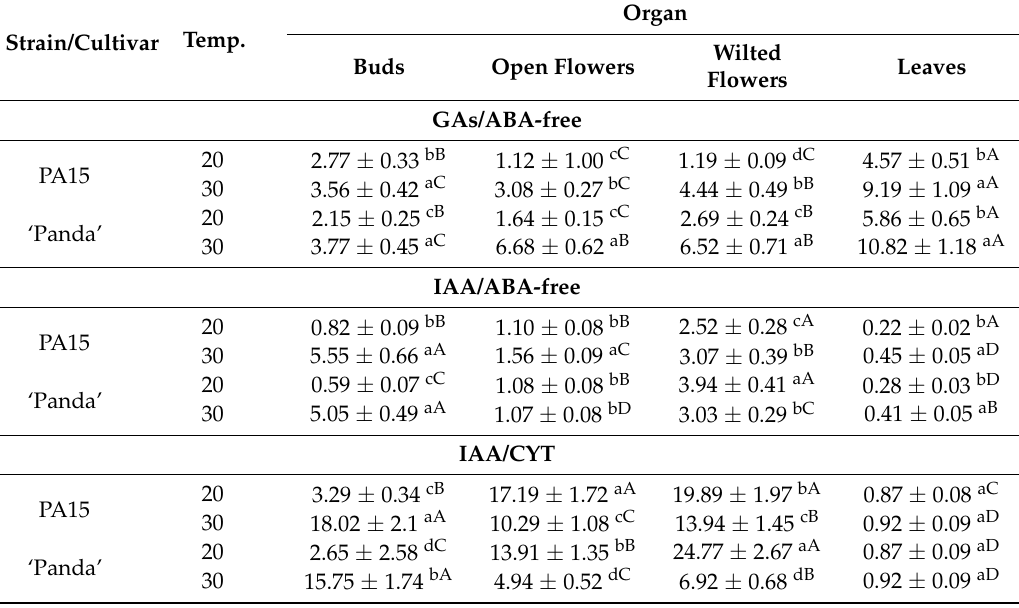
Table 4. Ratios of GAs* to ABA-free, IAA to ABA-free, and IAA to total cytokinins (CYT) in buds, well-developed flowers, wilted flowers, and leaves of common buckwheat plants grown at 20 ◦ C (control) and 30 ◦ C (thermal